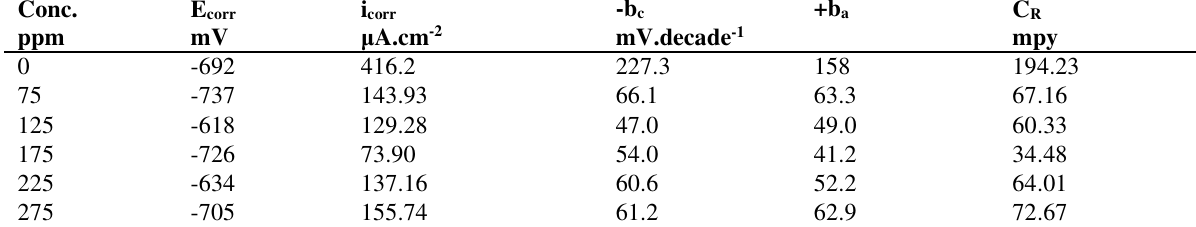
Measured data of polarization behavior for inhibition at 30 o C in 0.5M H 3 PO 4 solution.